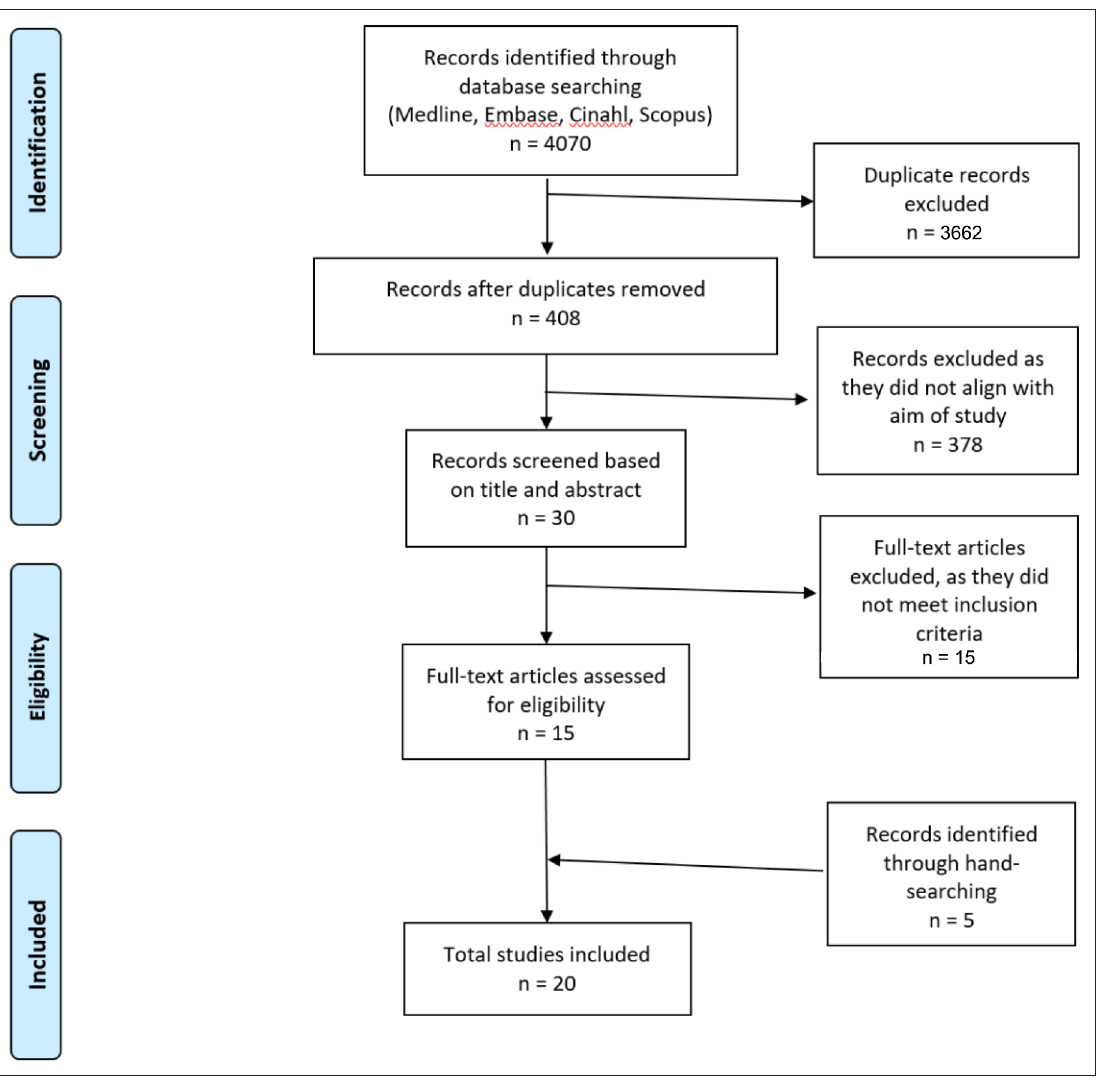
Figure 1 PRISMA flowchart of the selection process From, Moher et al .